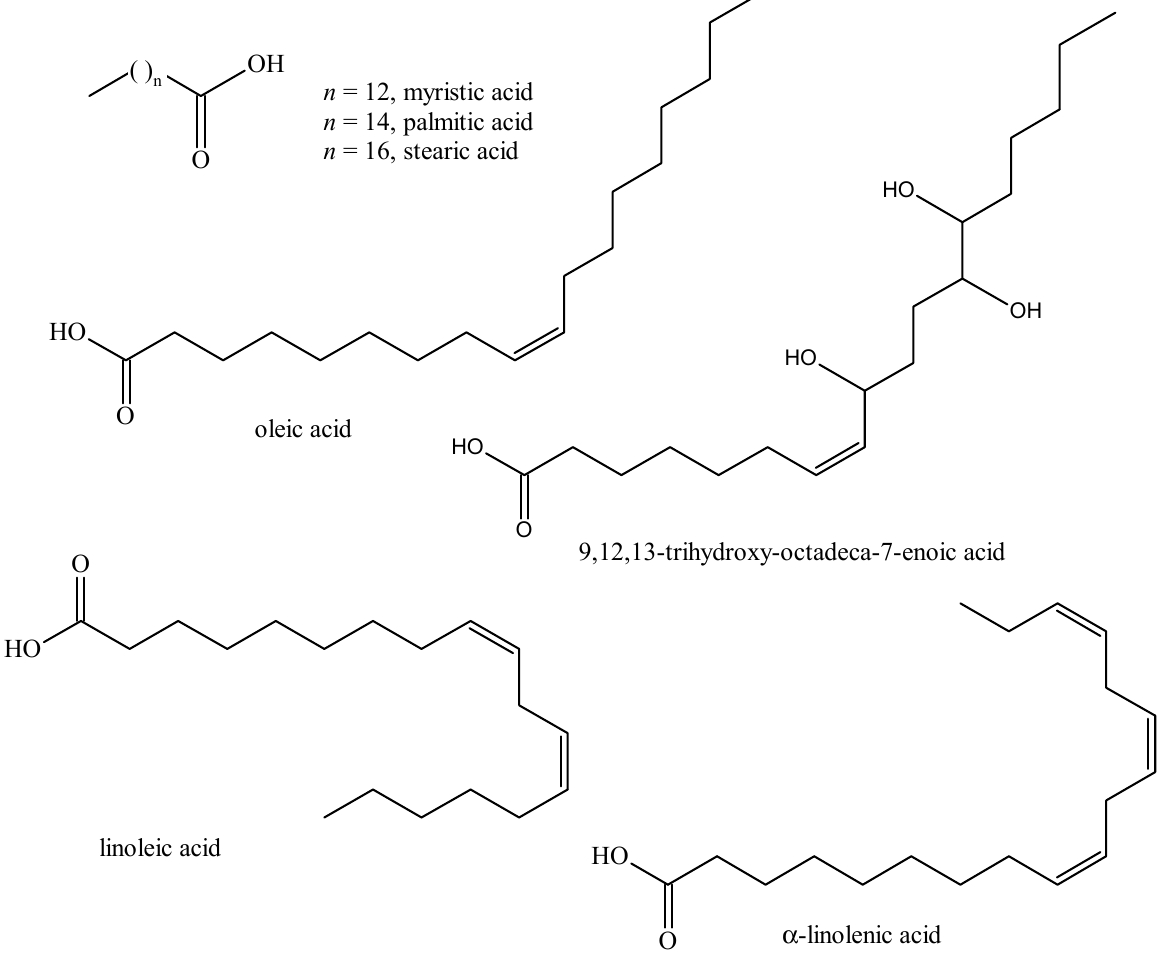
Figure 10. Structures of most common fa tt y acids in Allium spp.